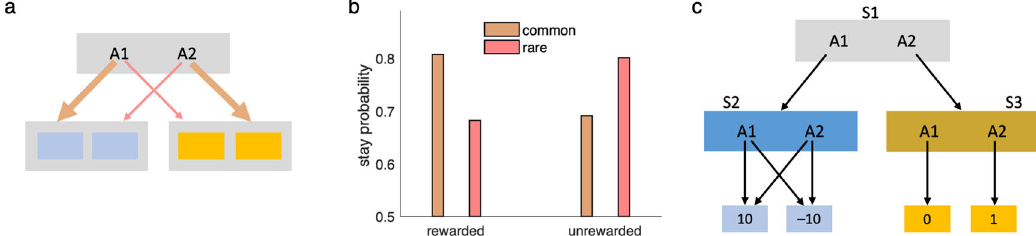
Fig. 6 Linear RL in environments with stochastic transitions. a The two-step Markov decision task, in which fi rst-stage actions A1 and A2 stochastically transition to second-stage states. b Linear RL solves this task similar to classical model-based learning, such that the effect of reward (vs nonreward) on the subsequent fi rst-stage choice (stay or switch, with respect to that on the current trial) depends on the type of transition (common: 70%; rare: 30%). c A task with stochastic transitions that linear RL fails to solve. Here, taking A1 and A2 at S1 deterministically leads to S2 and S3, respectively. However, taking either of A1 and A2 in state S2 stochastically leads to two different states with 10 and – 10 reward (with 50 – 50% chance). Therefore, expected value of state S3 is higher than that of S2, and A2 is the optimal action in S1. Linear RL incorrectly chooses A1 in S1,